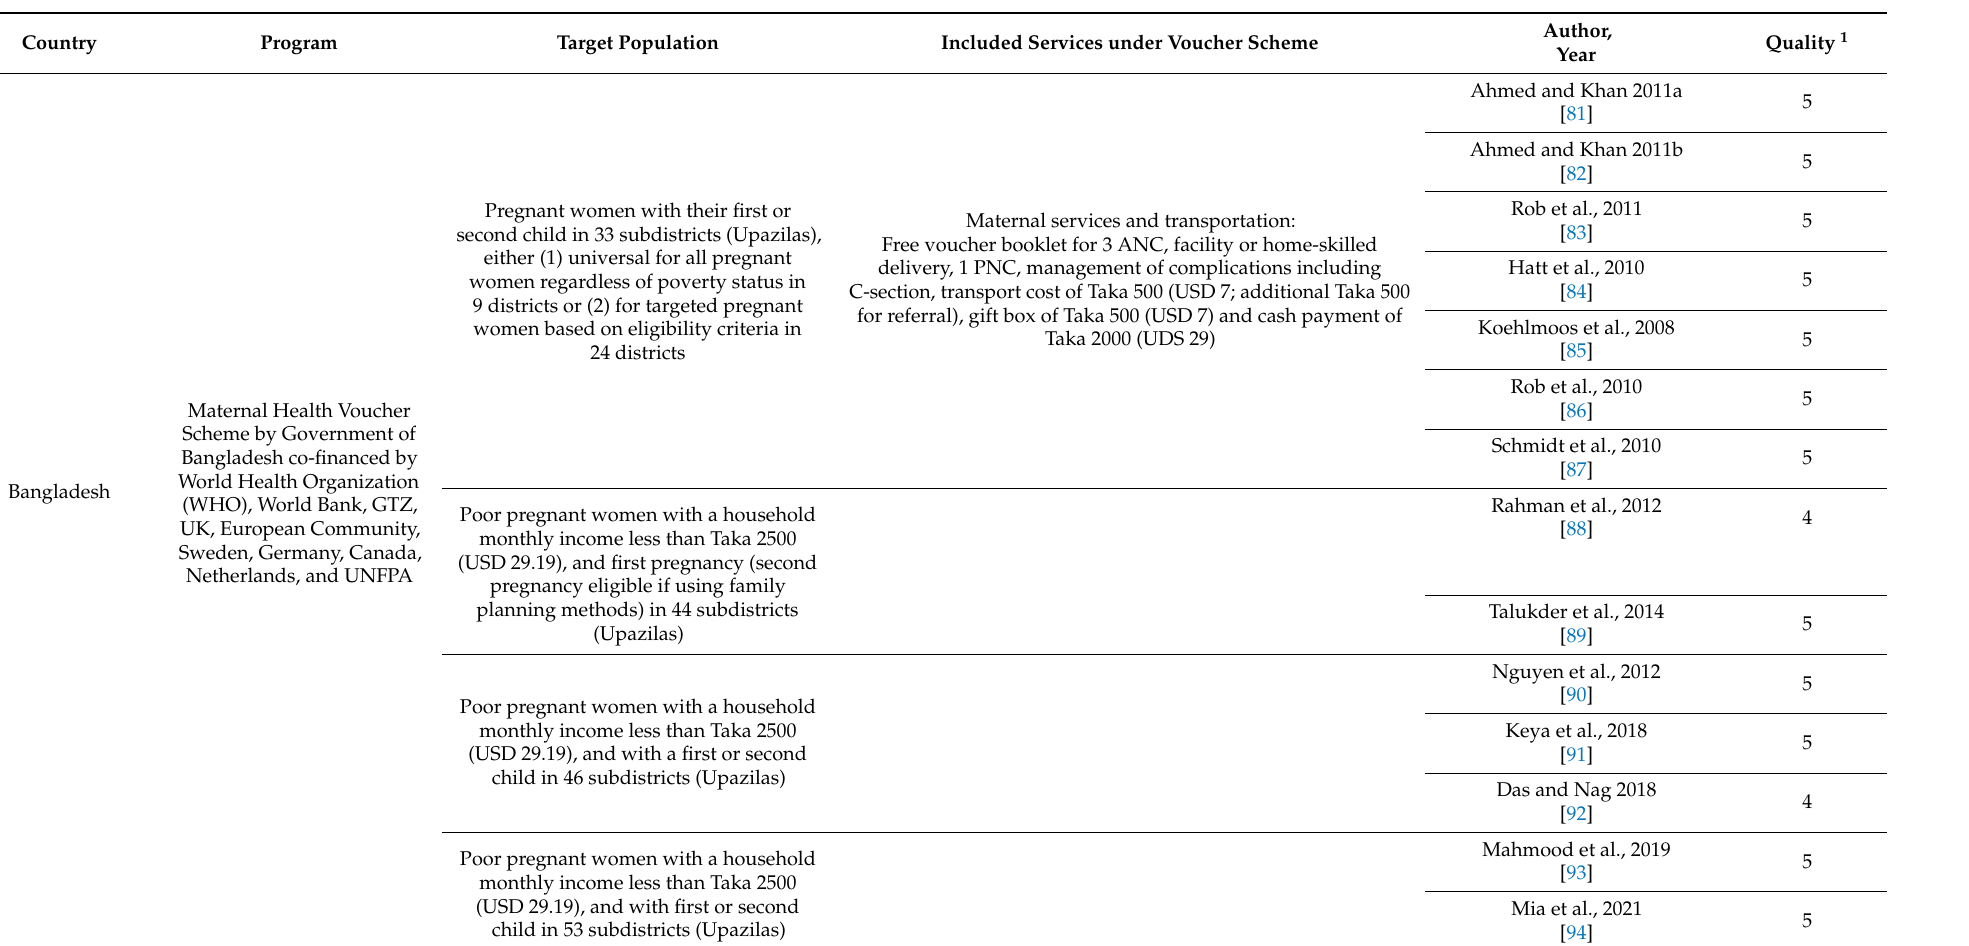
Table 2. Summary of included studies for Asia and the Middle